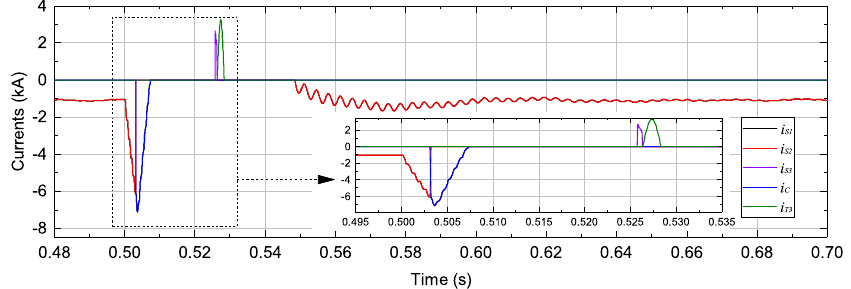
Figure 11. Overall currents on the switches of HCB 4.